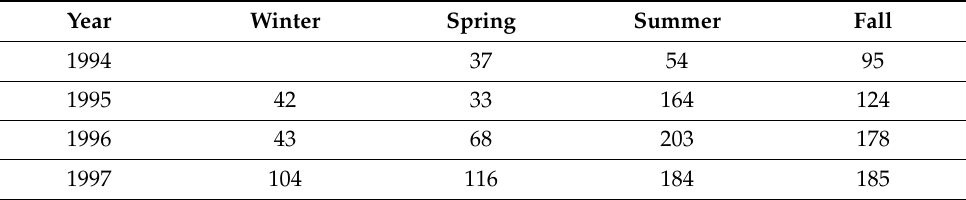
Table 2. Annual (1994–1997) seasonal averages of total phosphorus concentrations (ppb) in the Lake Agmon-Hula outlet: winter (January–March), spring (April–June), summer (July–September), and fall (October–December) [22].